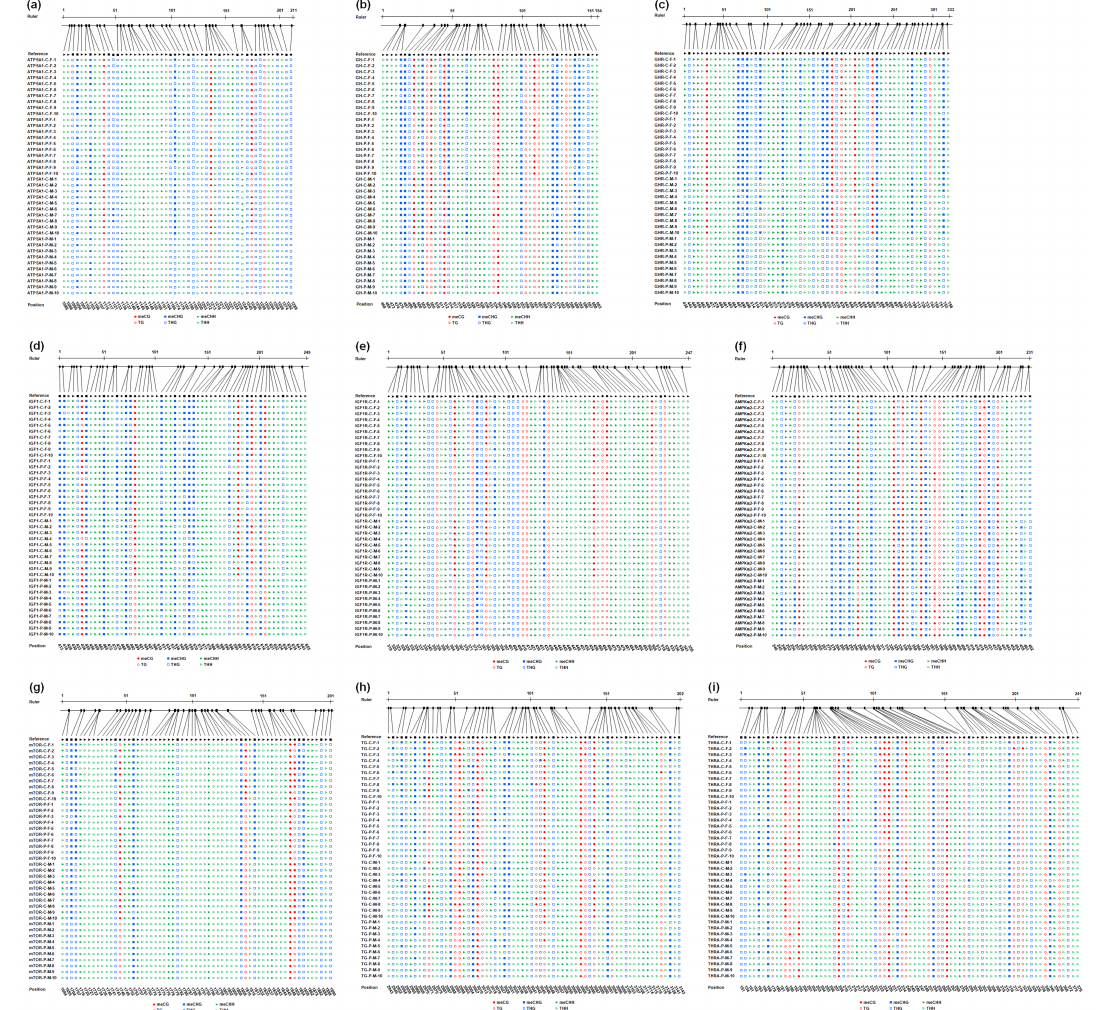
Figure 8. Cytosine methylation analysis in 90-day-old chickens. Bisulfite sequencing results